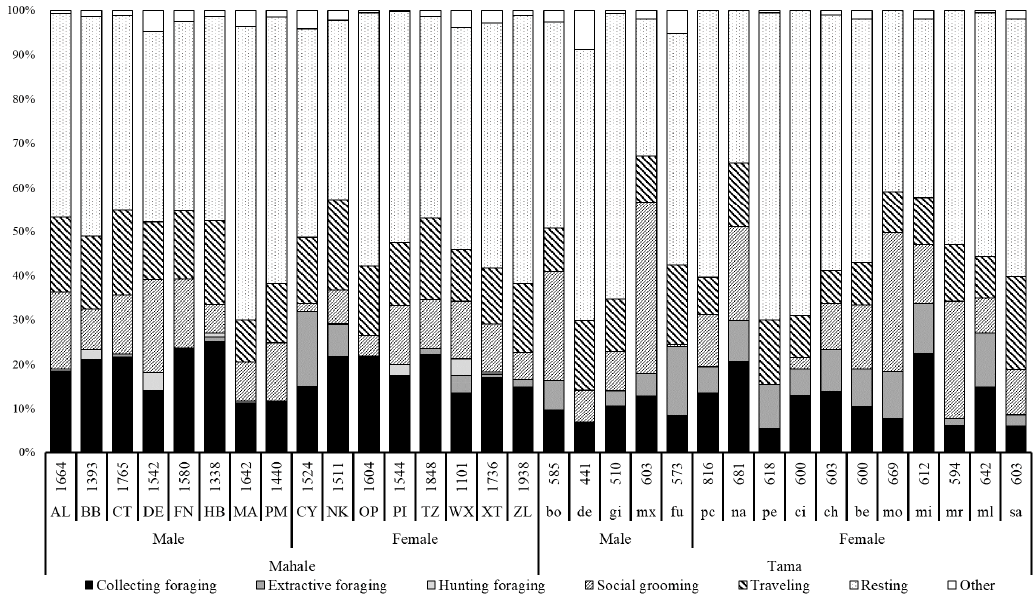
Figure 1. Percentage of time in each behavioral category for each individual in both groups. The numbers above the abbreviations of the focal individuals’ names indicate the total number of minutes that each individual was observed.